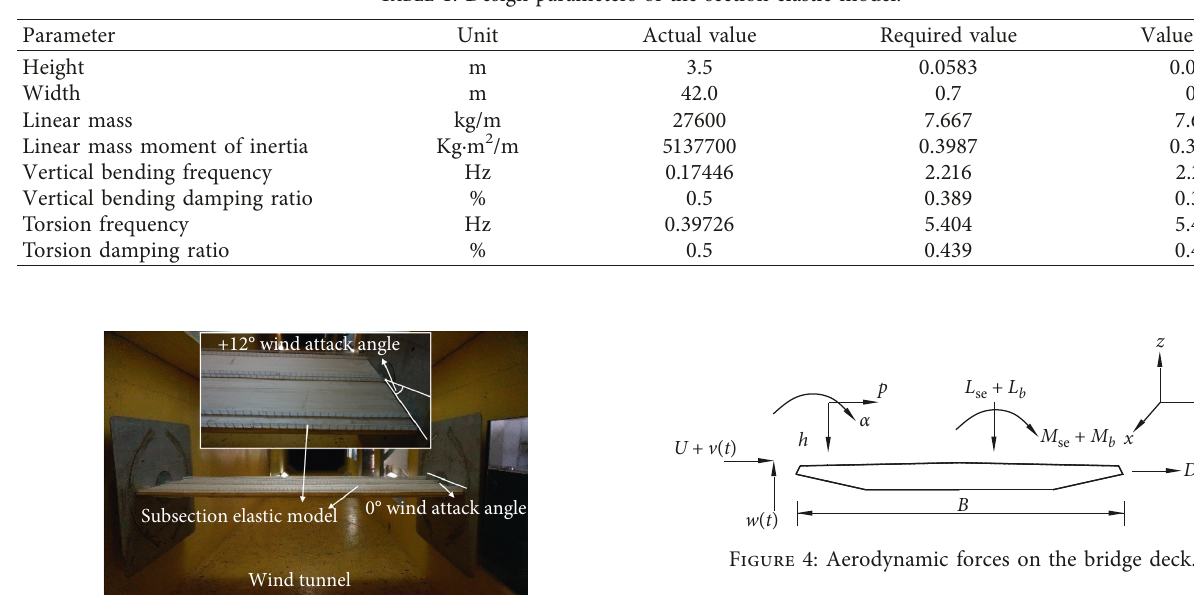
Figure 1: Dimensions of standard cross section (unit: cm). Table 1: Design parameters of the section elastic model.